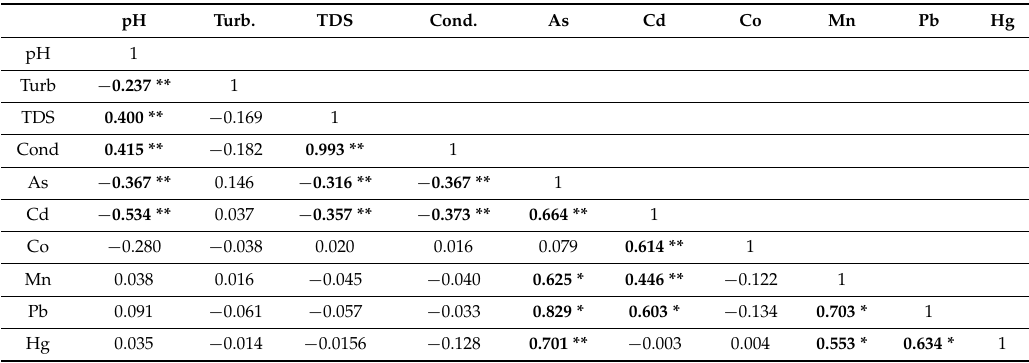
Table 5. Pearson Product-Moment Correlation Coefficients between water quality parameters in Tarkwa Nsuaem Municipality, Ghana ( n = 200). pH Turb. TDS Cond. As